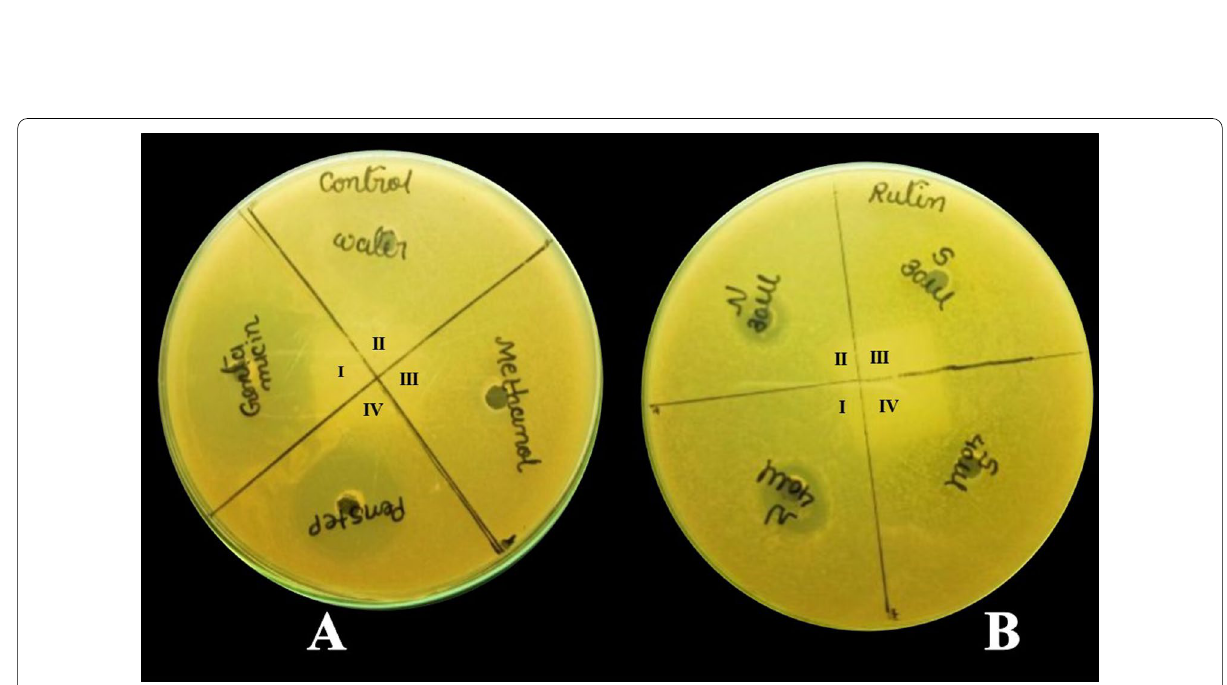
Fig. 13 Antibacterial activity against E. coli : Control: AI . Gentamicin, AII . DW, AIII . Methanol, AIV . PenStrep. BI . AgNPs (40 µl), BII . AgNPs (30 µl), BIII . Rutin (30 µl), BIV . Rutin (40